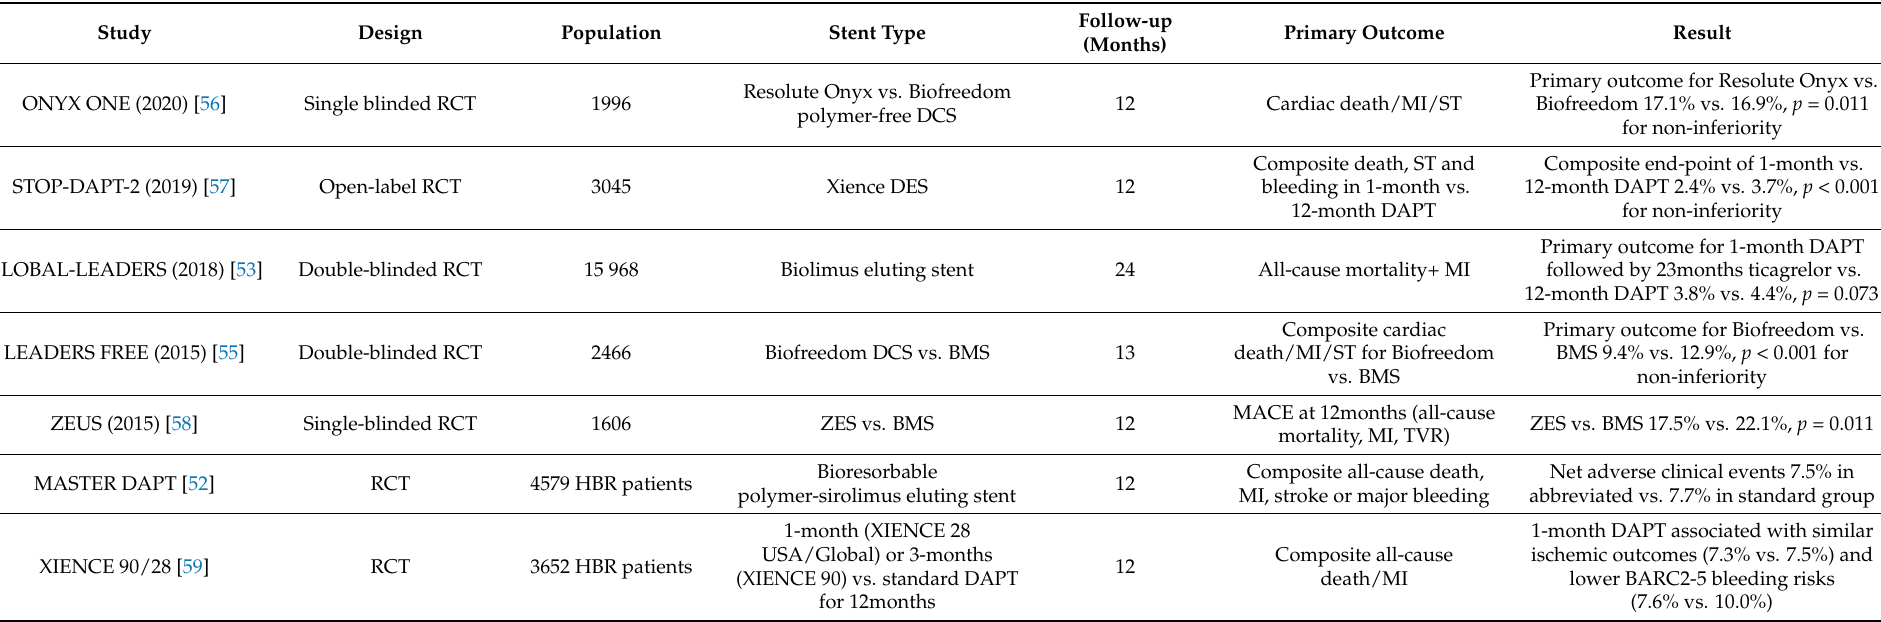
Table 2. Studies assessing 1-month DAPT following